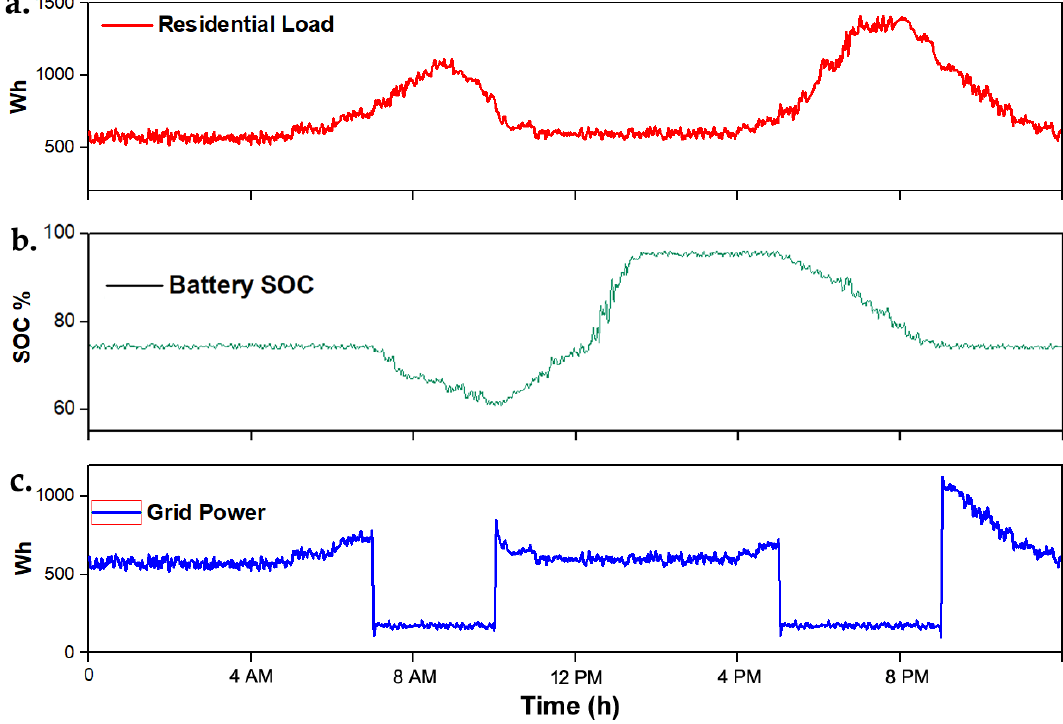
Figure 11. Status of ( a ) residential load, ( b ) battery state of charge (SoC), and ( c ) grid power during